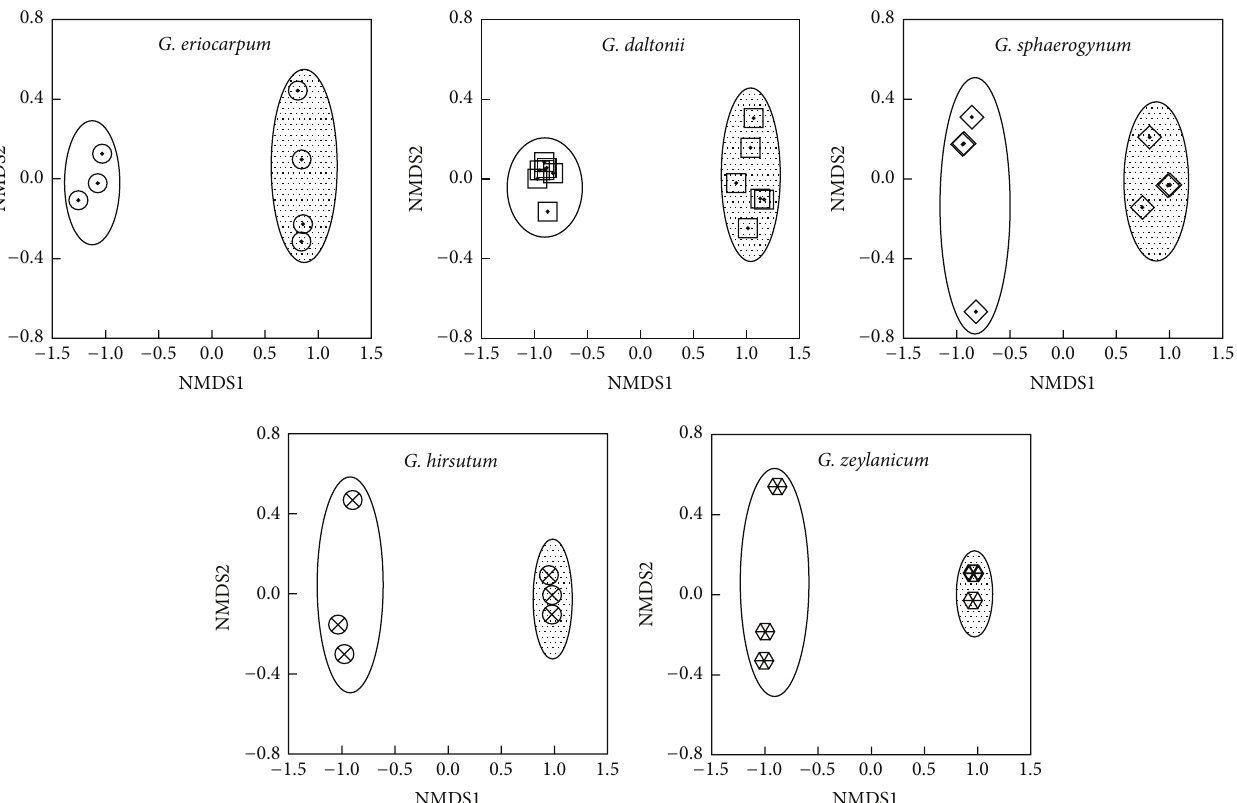
Figure 6: Score plots from NMDS of floral scents in male and female flowers of five Glochidion species. The headspace samples with each species are represented by different numbers sharp symbols as shown. The headspace samples within each species are boxed and coloured white for male flowers but grey for female